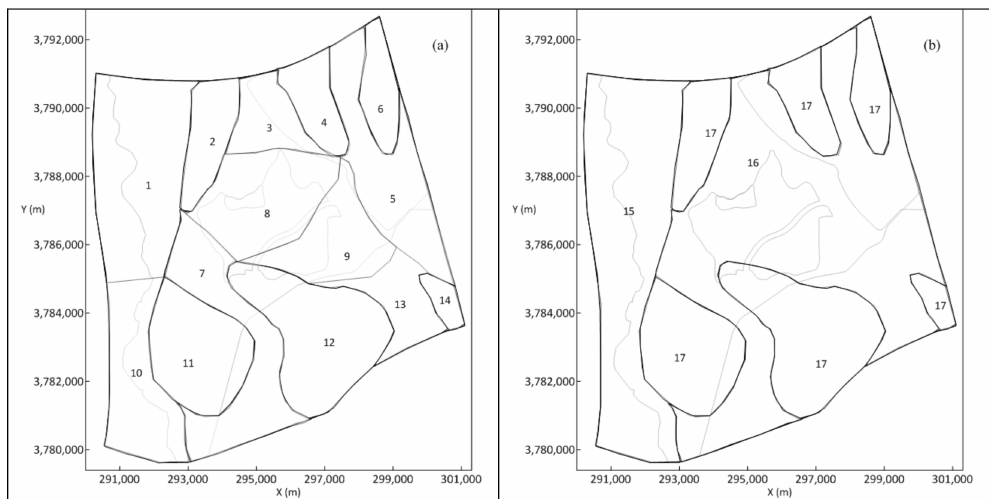
Figure 8. ( a ) The first-level parameter partition. ( b ) The second-level parameter partition. Model calibration and validation: The detailed calibration of the model from February 2017 to February 2018 using groundwater level measured in monitoring wells. The trial-and error method was selected for calibration. During the calibration process, hydraulic con- ductivity was calibrated to match the measured groundwater level contours, the